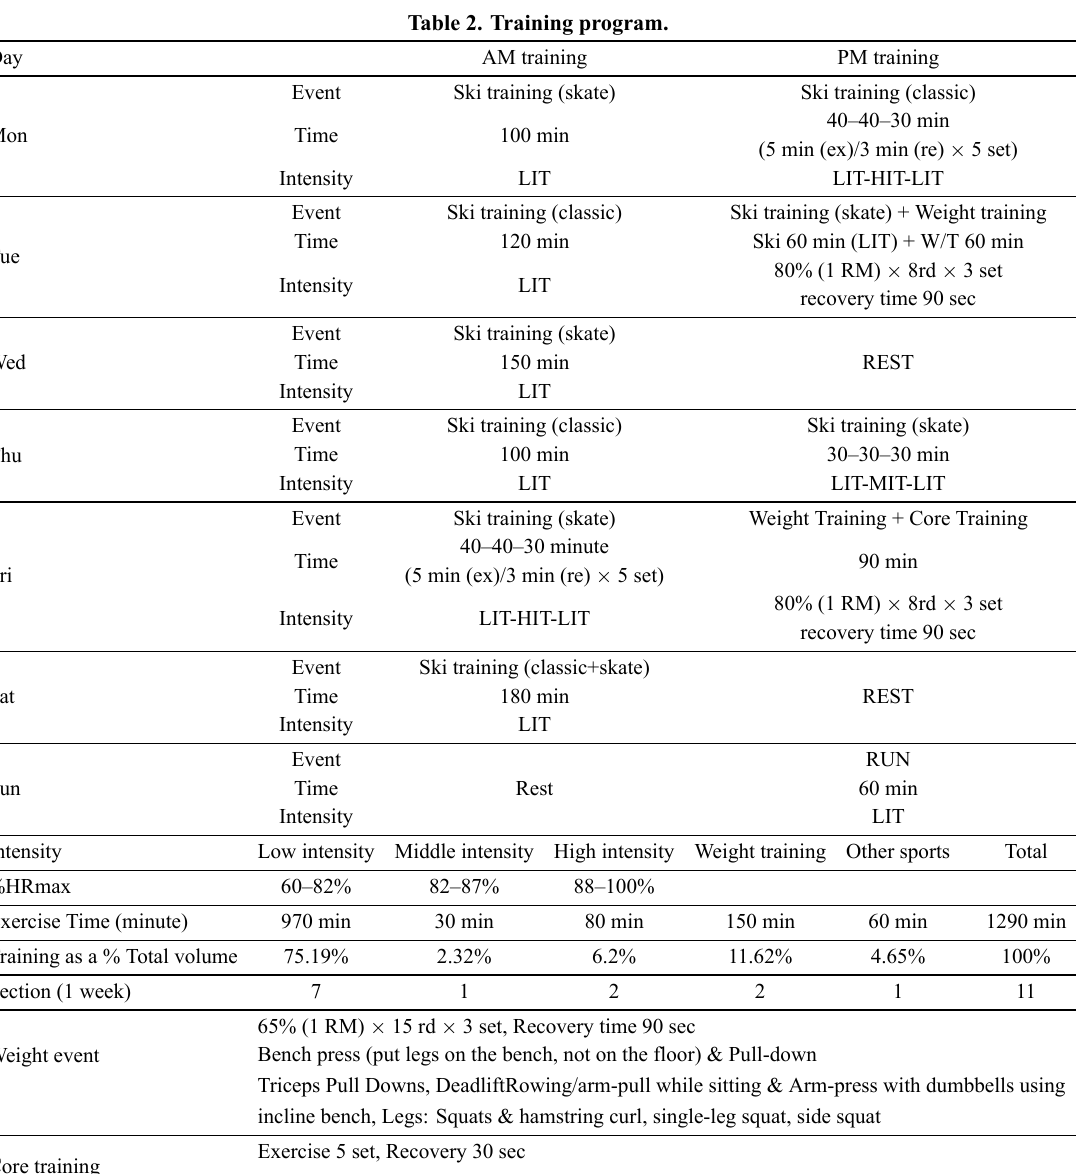
Table 2. Training